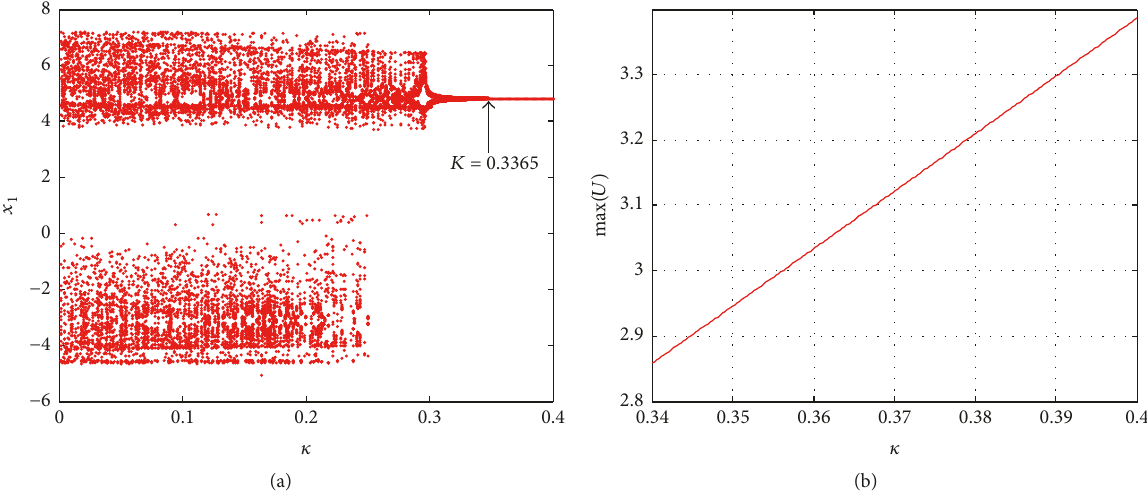
Figure 7: (a) Bifurcation diagram for control gain ( 𝜅 ). (b) Variation of the control signal 𝑈 for the gain variation ( 𝜅